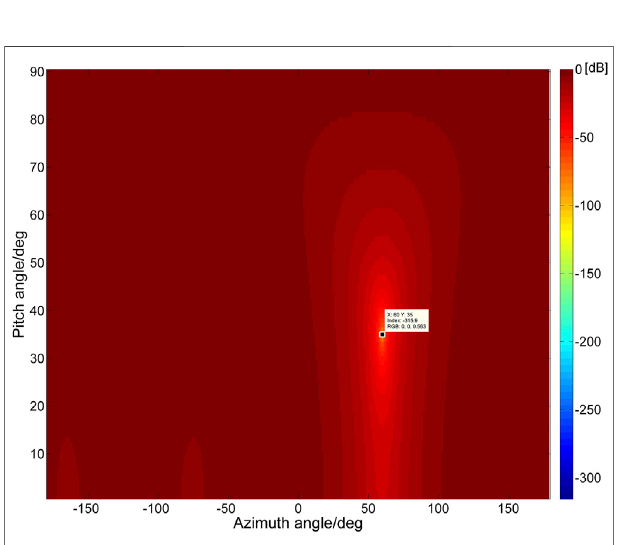
FIGURE 10 | Code Phase Results. The captured results of PRN one to six satellites signal after algorithm processing are shown in fi gures (A – D) .